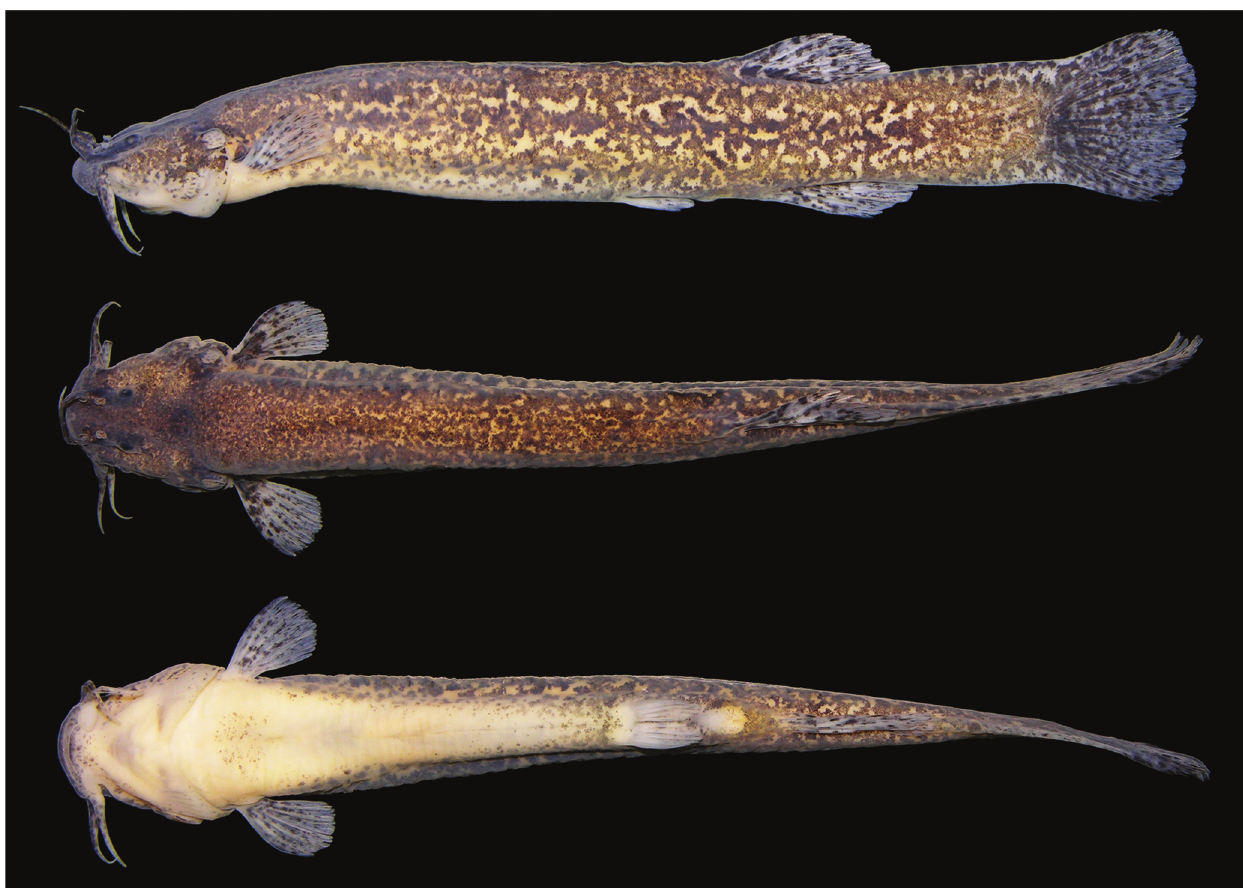
Fig. 13. Trichomycterus poikilos , holotype, UFRGS 16239, 63.3 mm SL, Brazil, Rio Grande do Sul State, municipality of